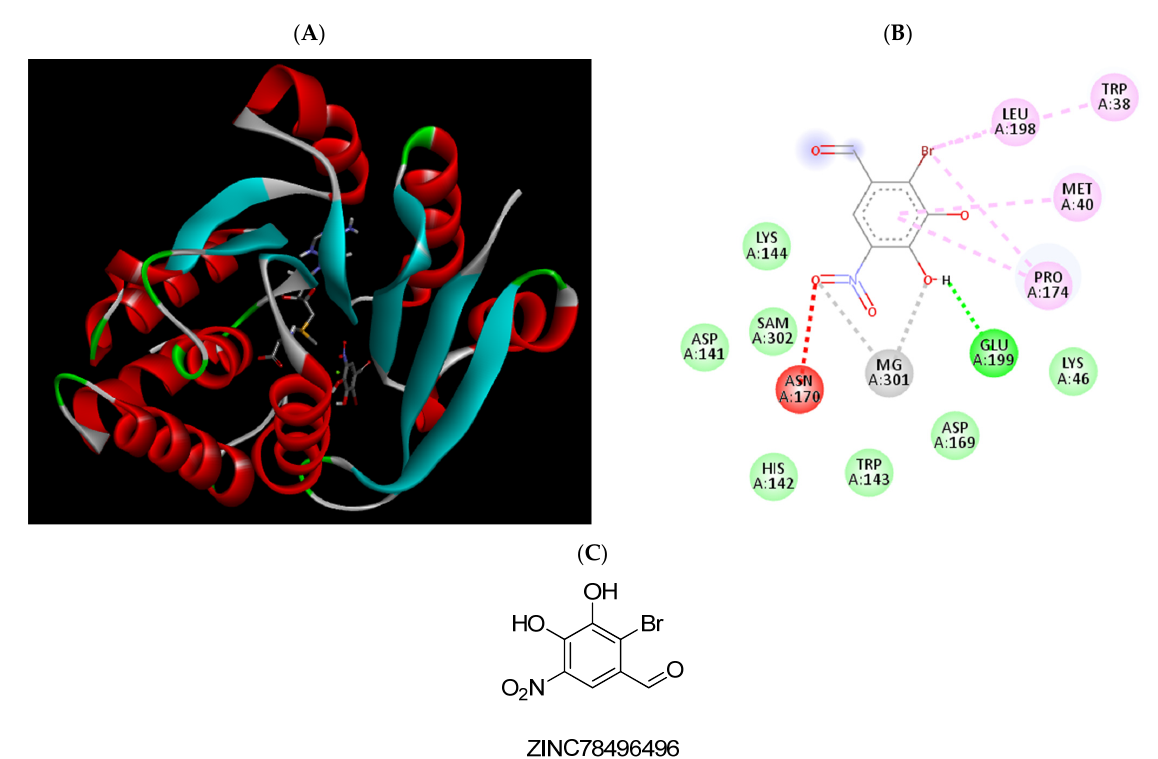
Figure 9. ( A ) Binding modes of ZINC78496496 with the crystal structure of human COMT complexed with SAM and Mg 2+ , ( B ) receptor–ligand interactions, ( C ) 2D representation of ZINC78496496.